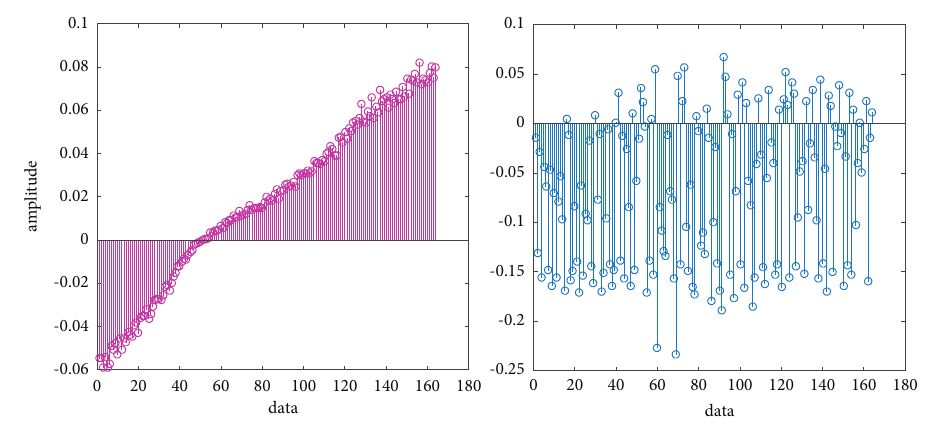
Figure 8: Amplitude